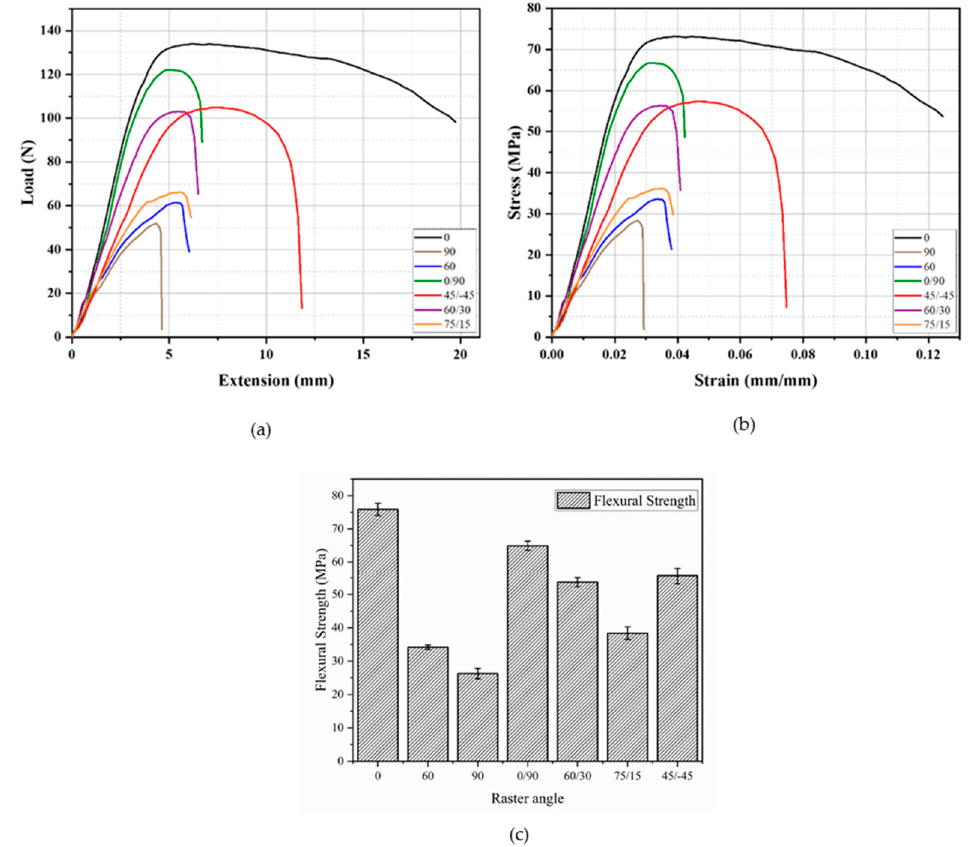
Figure 8. ( a ) In-plane load extension ( b ) in-plane stress–strain behavior for different raster angles; ( c ) comparison of in-plane flexural strength for different raster angles. ( c ) comparison of in-plane flexural strength for different raster